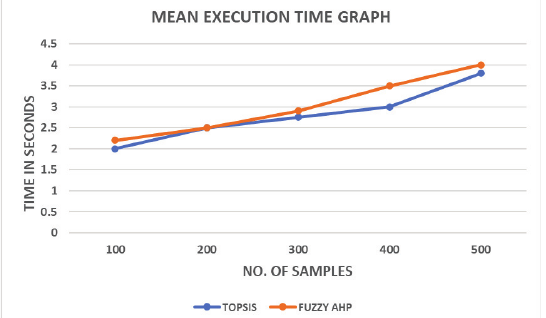
Fig. 3. Comparison of Mean Execution